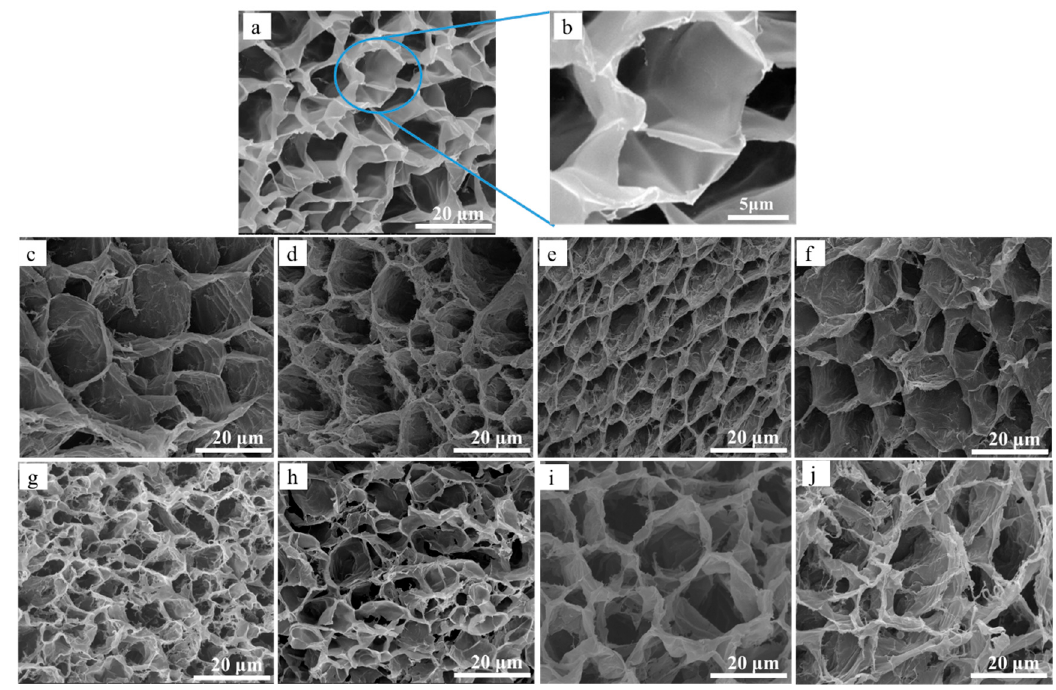
Figure 2. SEM images of ( a , b ) D-g-AA-2-120-8 aerogel; ( c – f ) CNC-g-AA-r-120-8 aerogels prepared with different AA contents (1, 2, 3, and 4 mL); ( g – j ) CNC-g-AA-2-120-n aerogels with different hydrothermal treatment times (2, 4, 8, and 12 h).